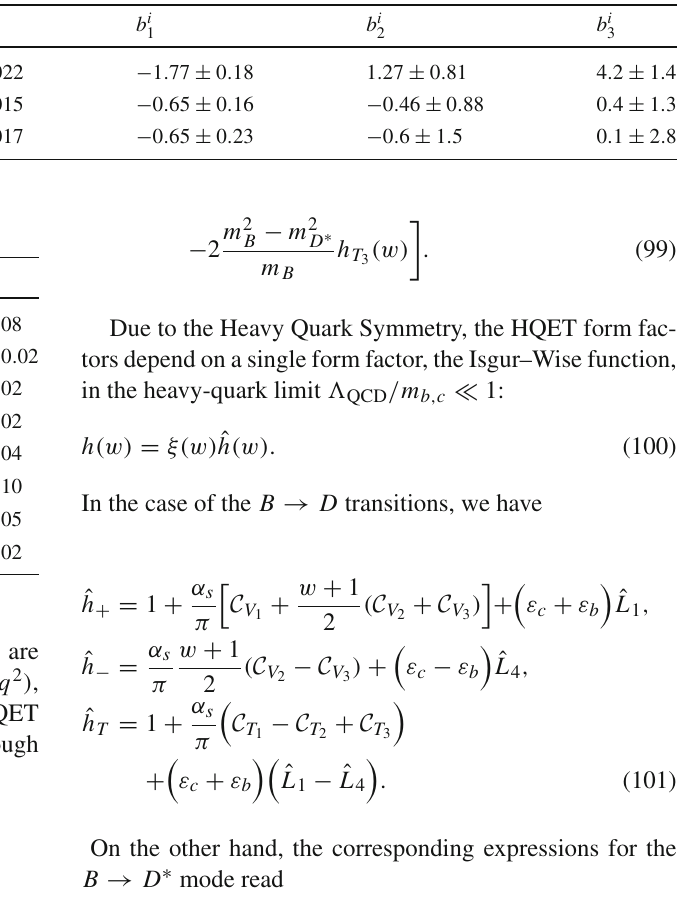
Table 16 Coefficients for the B → π form factors [46,47]